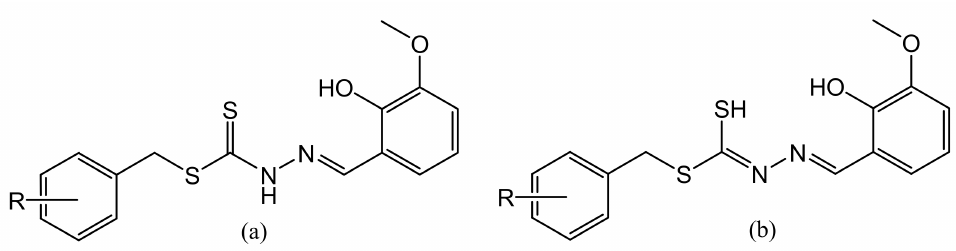
Figure 1. The thione ( a ) and thiol ( b ) tautomeric forms of the Schiff bases (R = o –CH 3 , S2MoVaH; p -CH 3 , S4MoVaH; R = H,